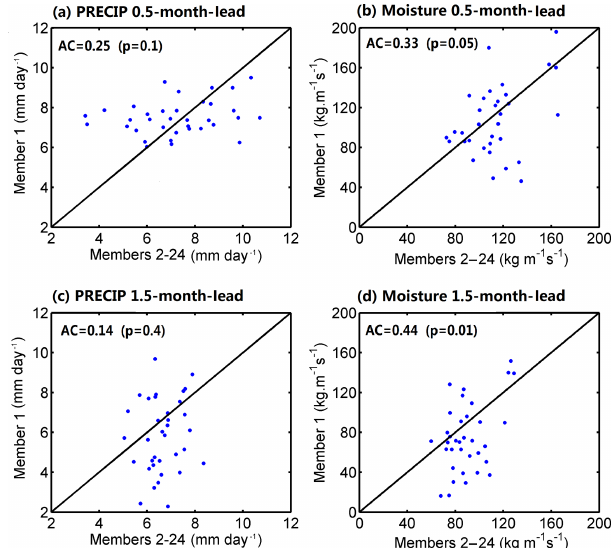
Figure 1. An example of the potential predictability calculation, where ensemble member 1 is the truth and the mean of members 2–24 is the prediction. This is for 116 ◦ E and 28 ◦ N near to Wuhan at (a–b) the 0.5-month lead and (c–d) the 1.5-month